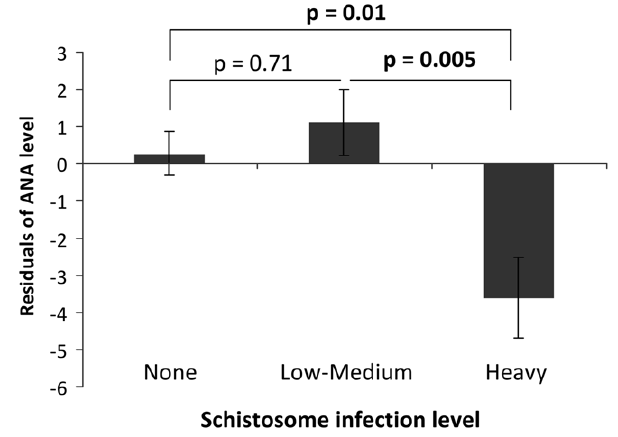
Figure 3. Relationship between anti-nuclear antibody (ANA) and schistosome infection levels. Bars represent residual variation in ANA levels after allowing for the variation due to host sex, age group, HIV status and